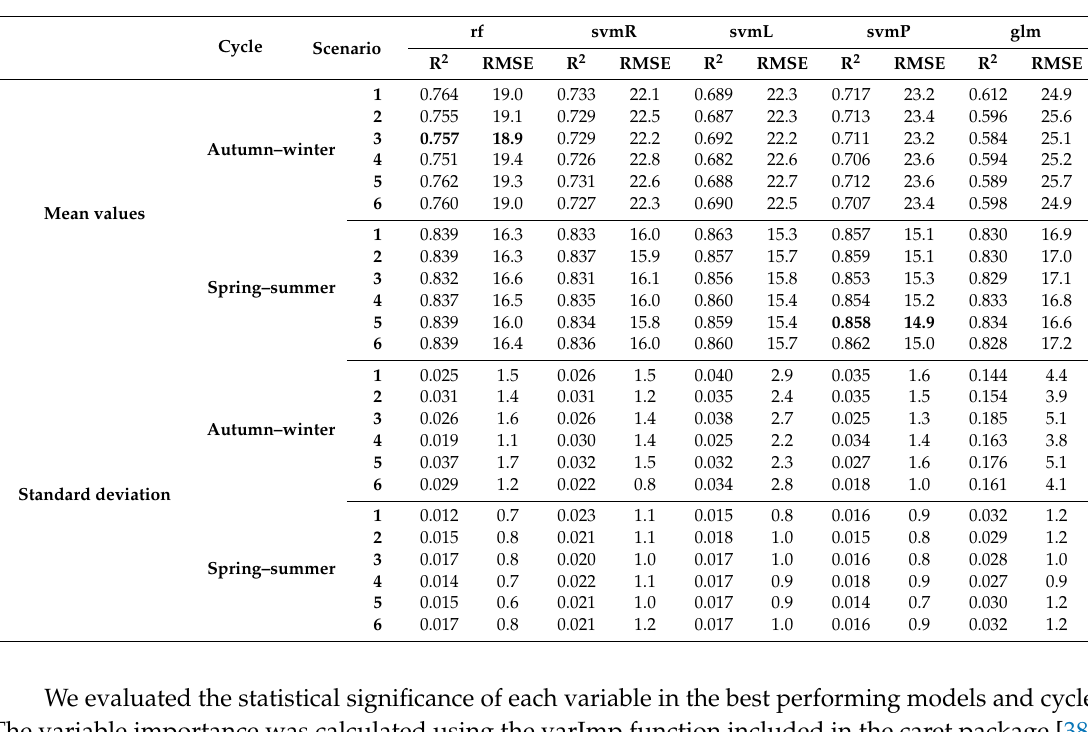
Figure 4. Variable importance of the svmP model, 5-month scenario, and summer cycle using bootstrapping method (25 repetitions) and one iteration. The variable importance shows in Figures 3–4 is only representative and depend on the random selection of the data. In order to perform a deeper analysis of the variable importance, the results of the 50 iterations have been calculated. In the winter cycle, the most important variable for the best performing model (rf, 3-month scenario) was the ybYield in 48 out of 50 iterations. In decreasing